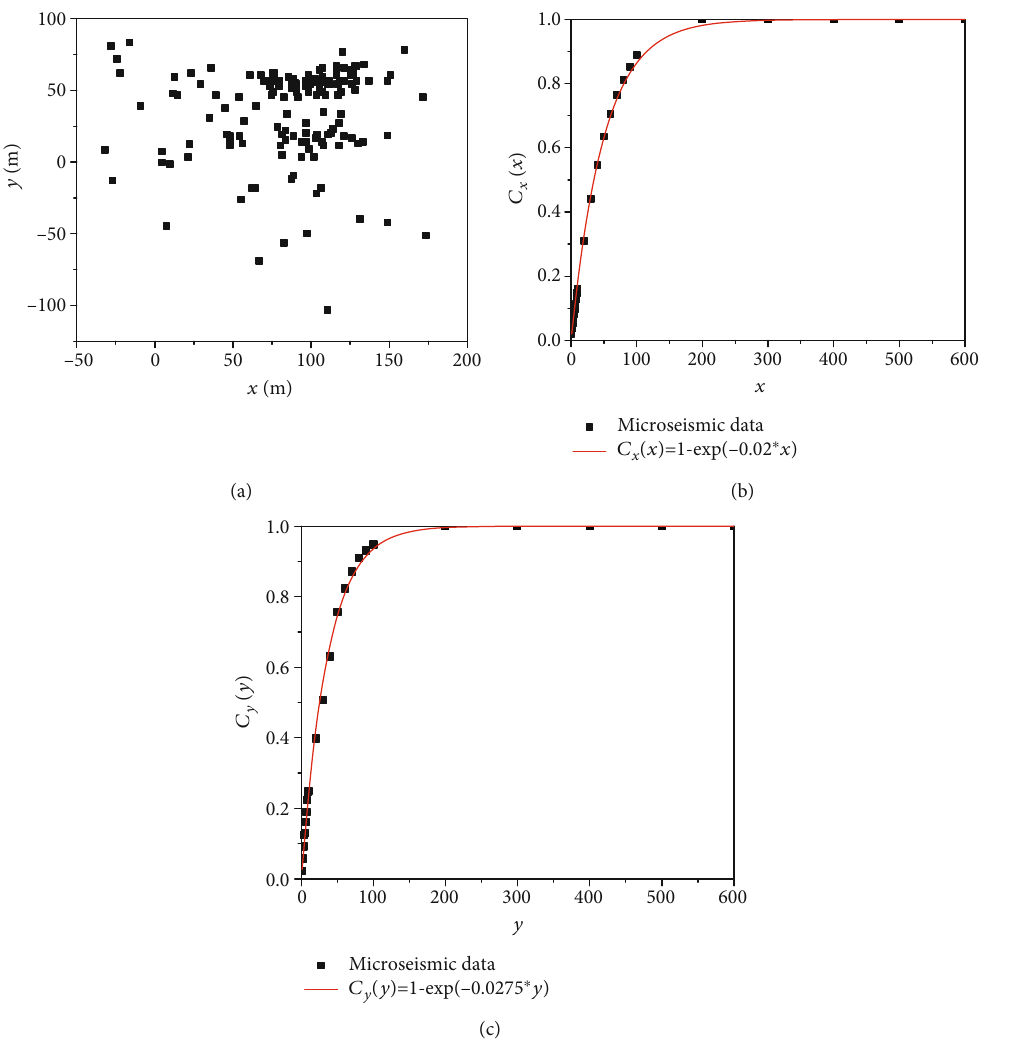
ð x Þ along the x direction, and x